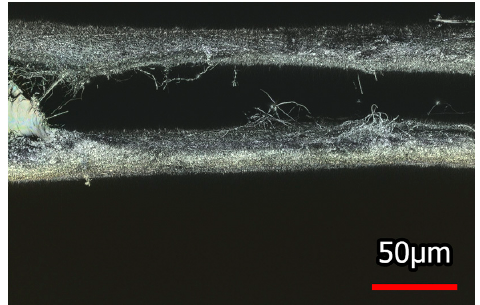
Figure 4. Nanofiber mats joined with thermoplastic polyurethane adhesive film.